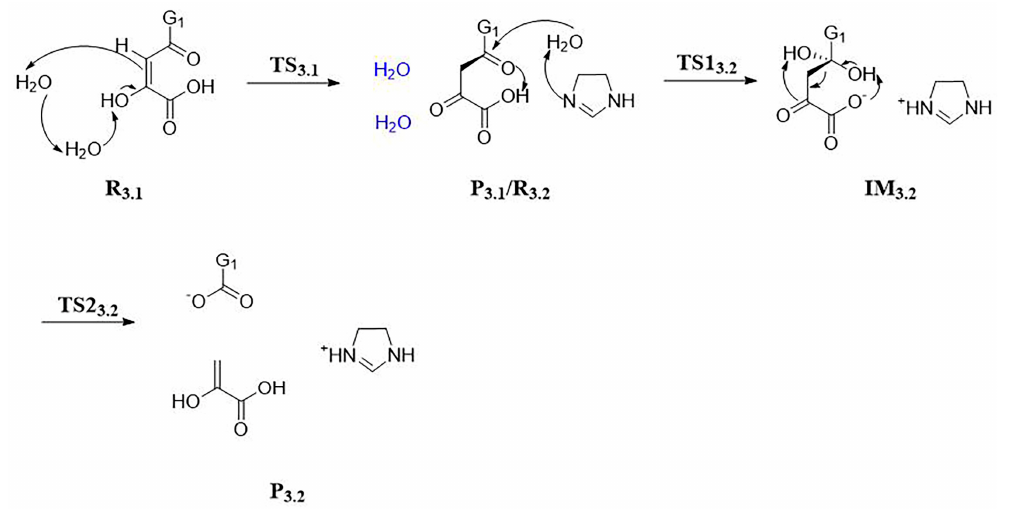
Scheme 7. The reaction process and predicted reaction mechanism of Stage 3. Blue molecules rep- resent product molecules not involved in the next reaction. Group G 1 is shown in Scheme